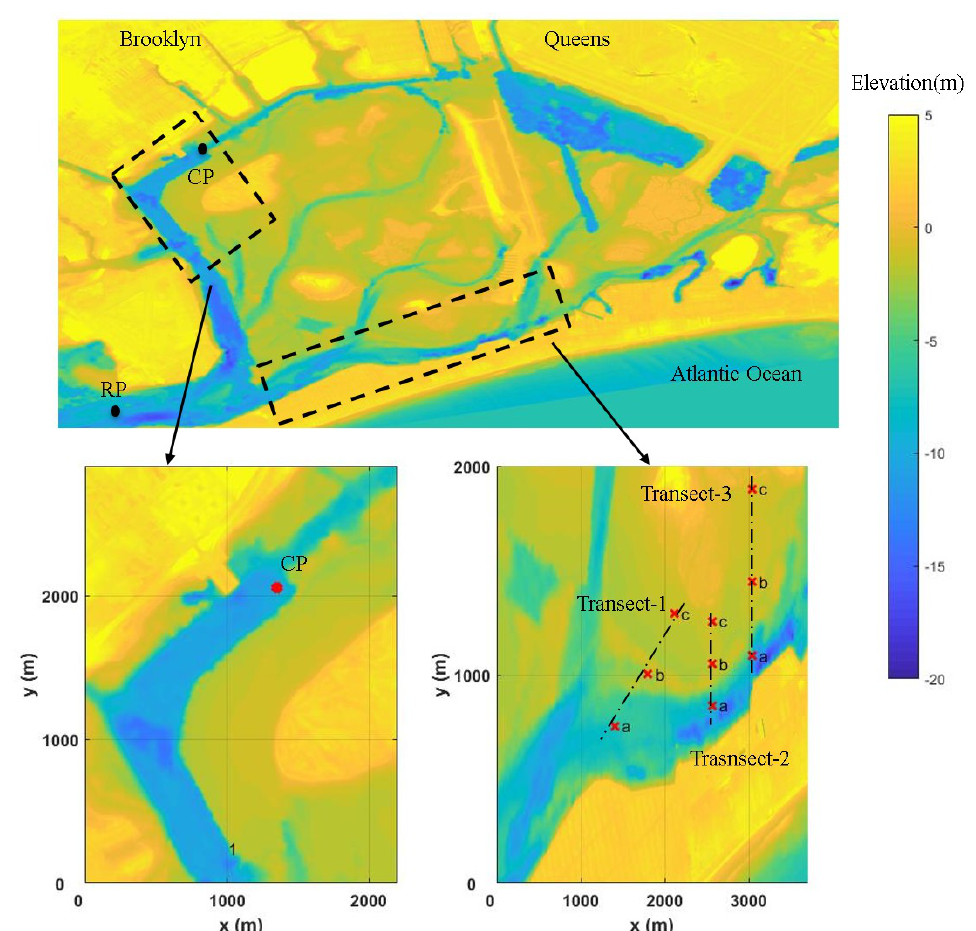
Figure 2. Topo-bathy of Jamaica Bay (top panel) and computational domains of the numerical model (bottom panels). Units are in meter. Vertical datum is mean sea level. Dashed-rectangles represent the boundaries of computational domains (bottom left panel for ship wake model evaluation; bottom right panel for wake-induced marsh erosion numerical experiments). Solid circles represent the location of wake measurement (labeled as CP and RP). Dash-dotted lines and cross signs (labeled a, b, and c) represent locations where model results are presented and discussed.